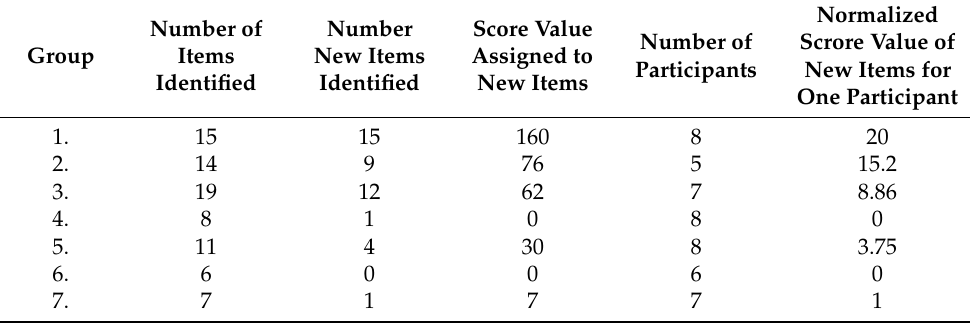
Table 2. Number of Items and Distribution of Importance Score in the Focus Groups.